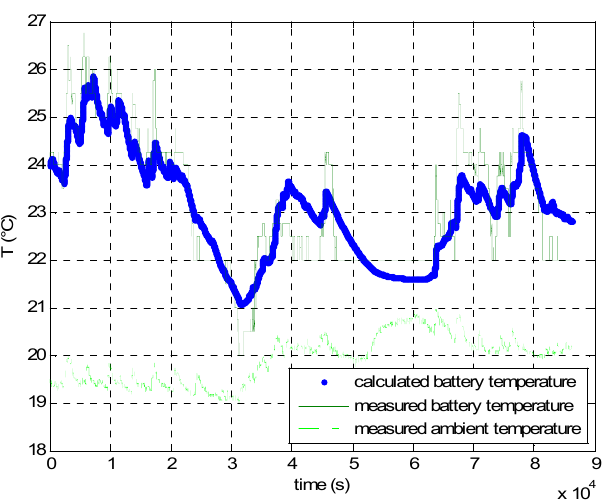
Figure 11. PFC tests, measured and calculated battery mean temperature T m , and measured ambient (cabinet) temperature T 0 , vs. time.